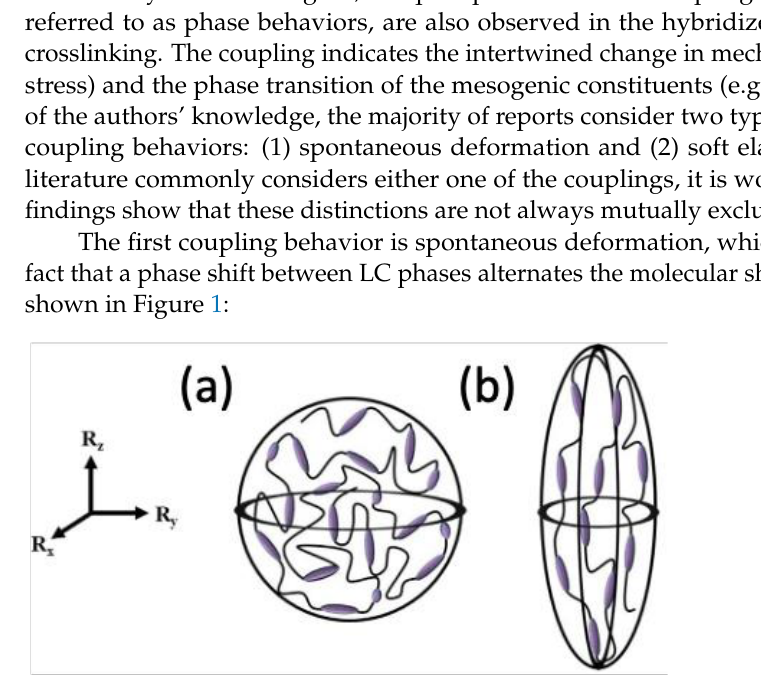
Figure 1. Microscopic description of polymer conformations: ( a ) spherical shape with isotropic LC phase and ( b ) prolate shape with nematic LC phase that is oriented with the director vector R z (Adapted with permission from Ref. [4]. 2018, Sabina W. Ula et al.). The differences in the stress-free configuration induce deformation to accommodate a change in the metric tensors, which is analogous to warpage caused by residual strain. The term “spontaneous” originates from the fact that the stress state within the body does not change when left unconstrained. As shown in Figure 1, the polymer conformation changes its shape from a sphere (Figure 1a) to a prolate (uniaxial ellipsoid) shape (Figure 1b) as the LC phase shifts from isotropic to nematic. Such polymeric conformation at the mesoscale deforms the macroscopic